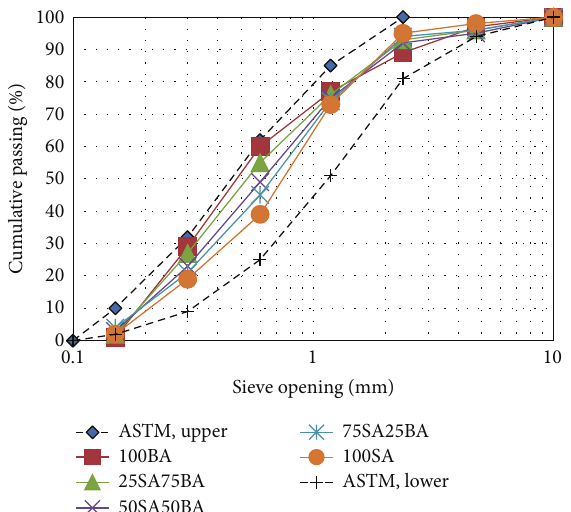
Figure 2: Particle size distributions of SA, BA, and combinations.